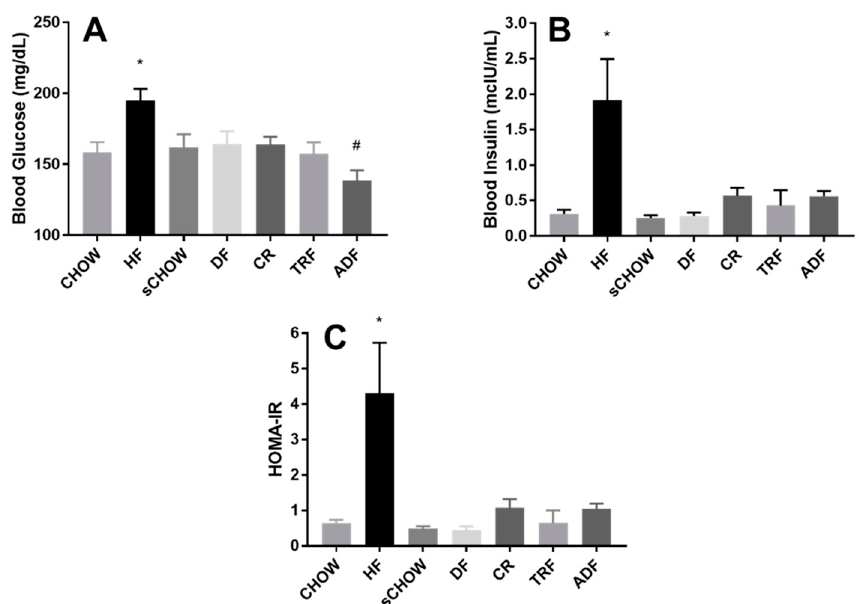
Figure 3. Post-intervention fasting blood glucose ( A ), fasting blood insulin ( B ), and HOMA-IR ( C ) of male C57BL/6 mice assigned to seven different dietary protocols for eight weeks. Values are mean ± SEM, n = 7–9 mice per group. ( A ) *A significant group effect noted: HF > all other groups ( p < 0.050); # A significant group effect noted: ADF < sCHOW, DF, and CR ( p < 0.050) (ANOVA); ( B ) *A significant